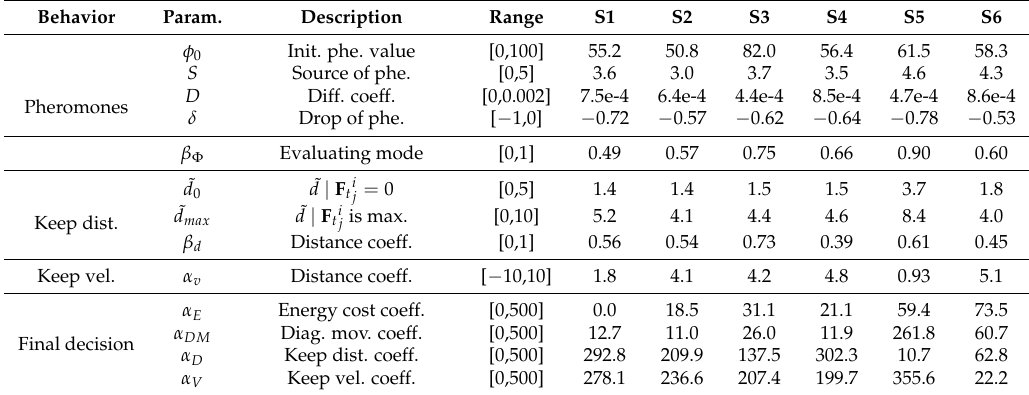
Table A1. Final values of each parameter of the algorithm for the different scenarios considered. S 1: N a = 4, V n = 0.10 m/s; S 2: N a = 4, V n = 0.15 m/s; S 3: N a = 6, V n = 0.10 m/s; S 4: N a = 6, V n = 0.15